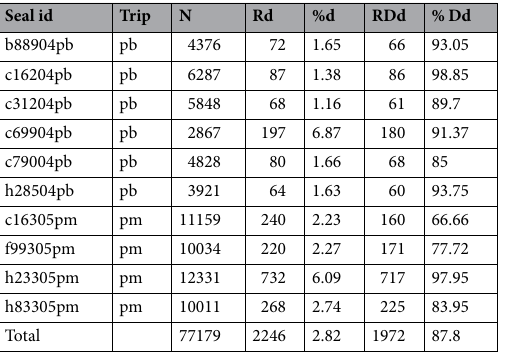
Table 4. Validation of the drift dive methodology with 10 independent Macquarie Island seals. Seal id = reference code for each individual tag/seal. Trip: pb = post-breeding trip, pm = post-moulting trip. N = Total number of dives recorded by each tag. Rd = number of retained dives after the application of our method. %d = proportion of dives retained from the total number of dives recorded. Rdd = number of retained drift dives. %Dd = proportion of the retained dives that were true drift dives, as determined by visual inspection of all retained dives using the original high resolution time-depth